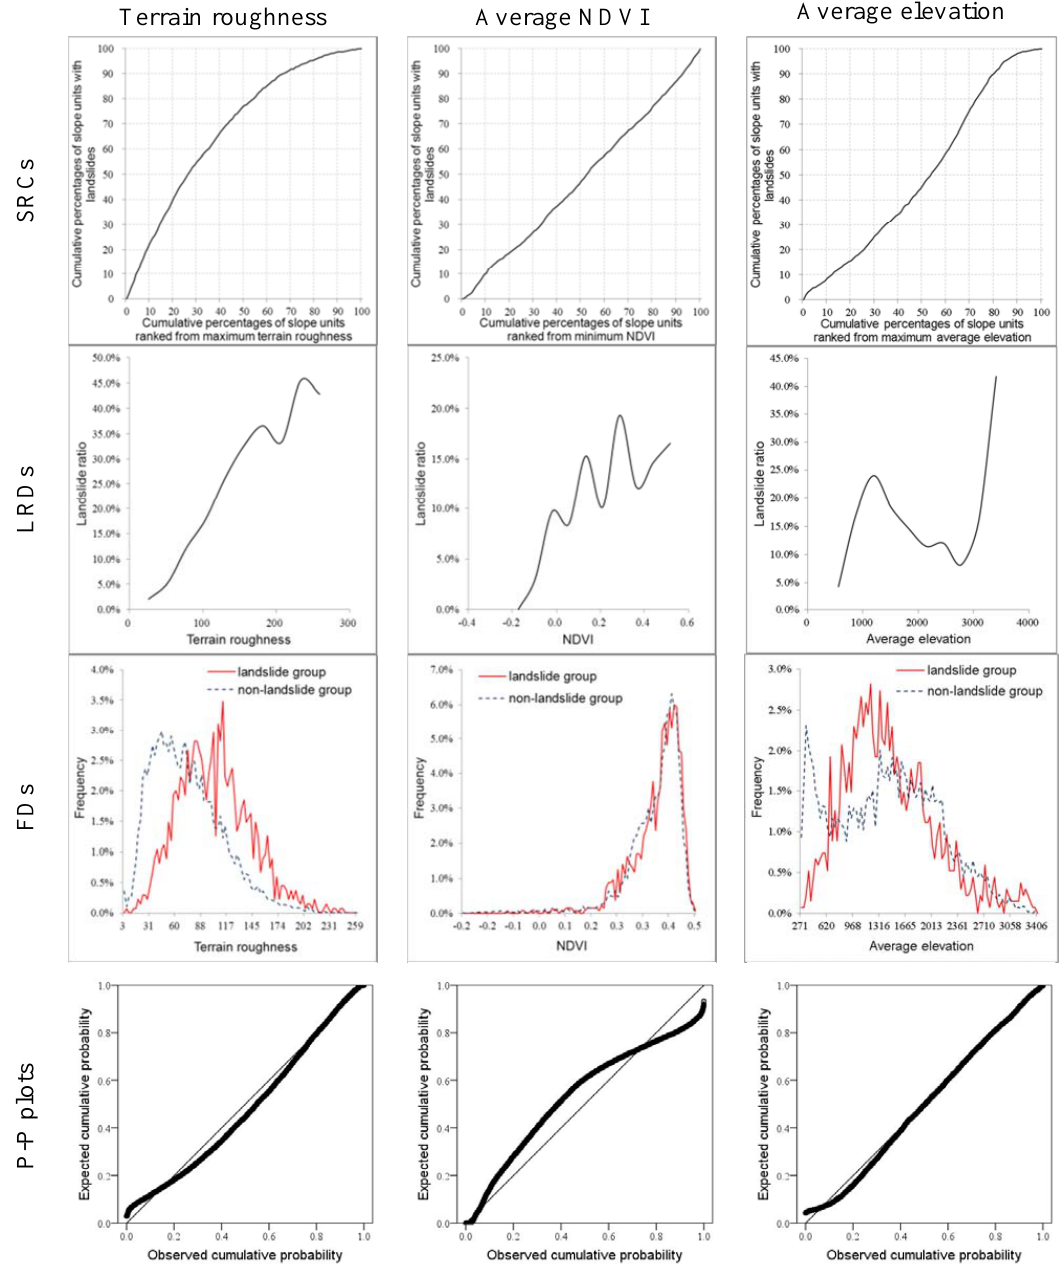
Fig. 3. Success rate curves (SRCs), landslide ratio distributions (LRDs), frequency distributions of landslide and non-landslide group (FDs), and probability-probability plots (P–P plots) of representative variables.